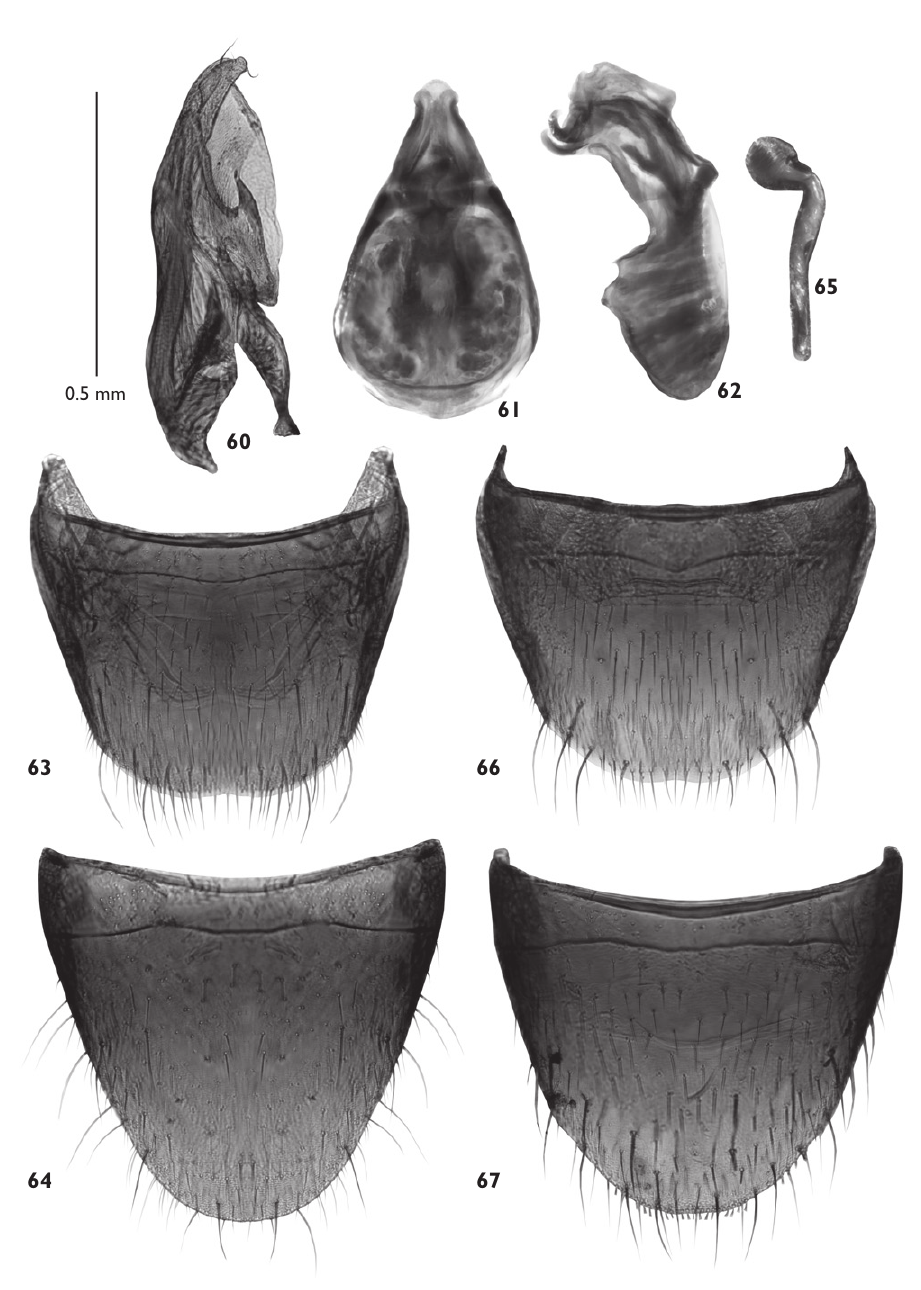
Figures 60–67. Schistoglossa carexiana : 60 paramere 61 median lobe of aedeagus in dorsal view 62 median lobe of aedeagus in lateral view 63 male tergite 8 64 male sternite 8 65 spermatheca 66 female tergite 8 67 female sternite